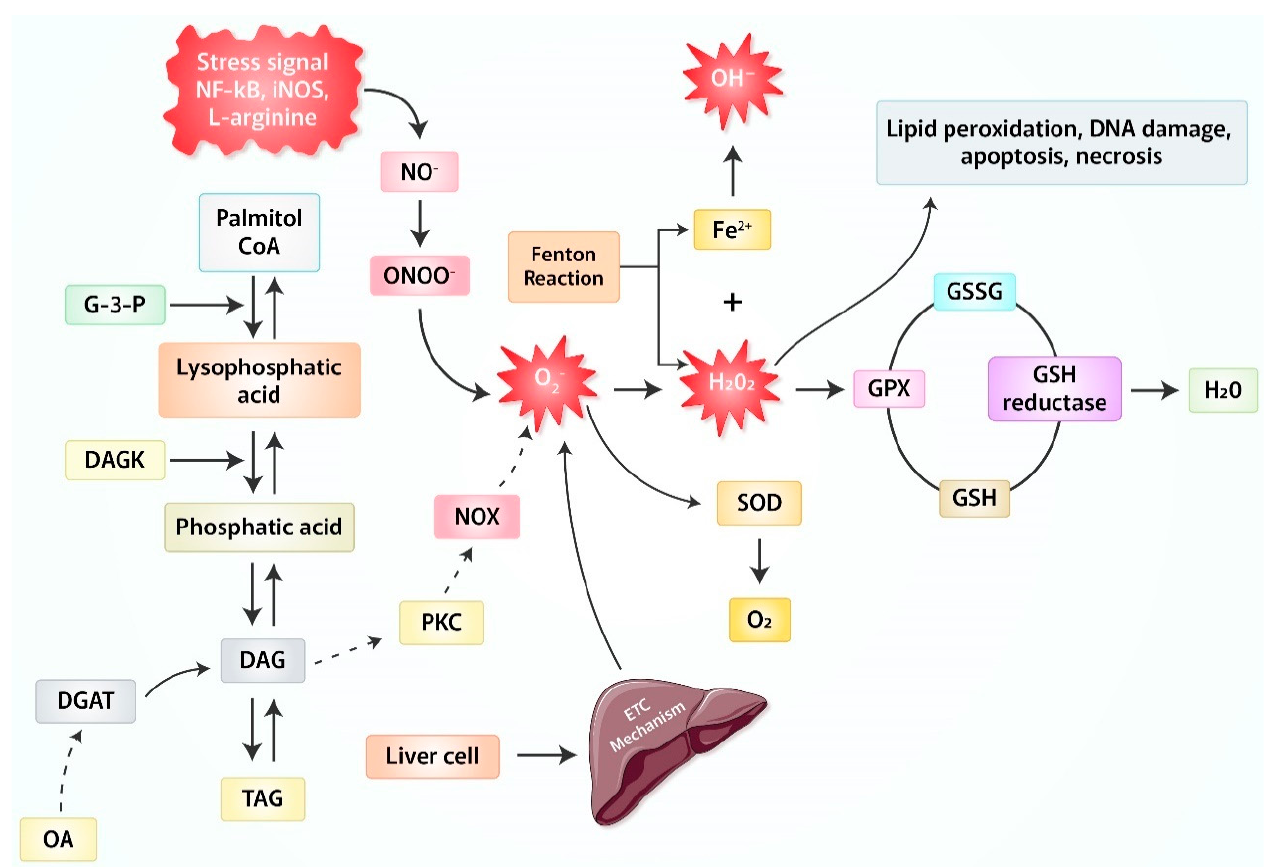
Figure 1. ROS production from oxidative stress. Locations at which ROS are produced. There are several distinct locations within a cell that are capable of producing ROS. The vast majority of them may be found in the mitochondrial surroundings. Glyceraldehyde-3-phosphate (GAPDH), diacylglycerol:acyltransferase (DGAT), diacylglycerol (DAG), triacylglycerol (TAG), peroxynitrite (ONOO − ), nitric oxide (NO), protein kinase C (PKC), glutathione peroxidase (GPx), superoxide dismutase (SOD), glutathione (GSH), GSH/oxidized glutathione (GSSH), electron transport chain (ETC), inducible nitric oxide synthase (iNOS).